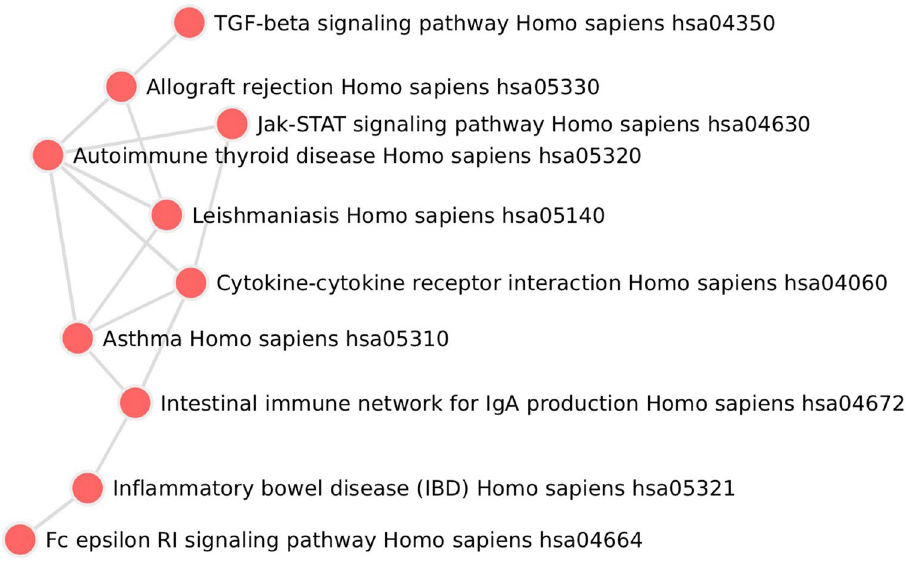
Figure 5. Network of top enriched human KEGG pathways for genes enriched from MSEA analysis using DA microbes in IL-1α-KO versus WT mice 8 days after DSS-administration. Nodes in the network are enriched human KEGG pathways. The pathways are connected if they have significant number of overlapping genes determined by Fisher’s exact